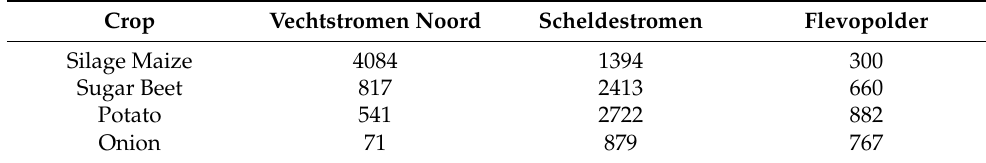
Table 1. Number of crop parcels per study area in